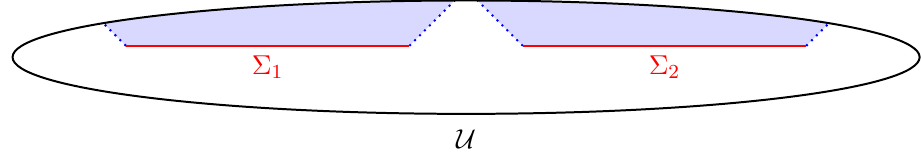
Figure 6 . With this choice of U , we have @ U \ J + ((cid:6) 1 ) \ J + ((cid:6) 2 ) = ; .